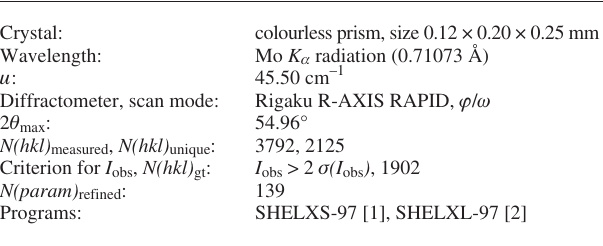
Table 1. Data collection and handling.